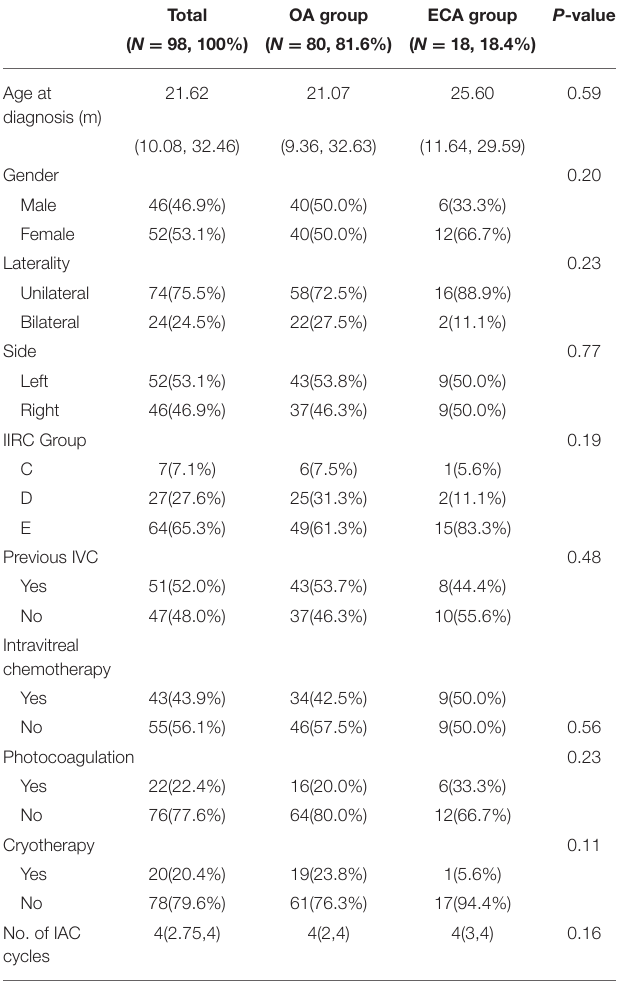
TABLE 1 | The demographic and clinical features of eyes receiving IAC. Total OA group ECA